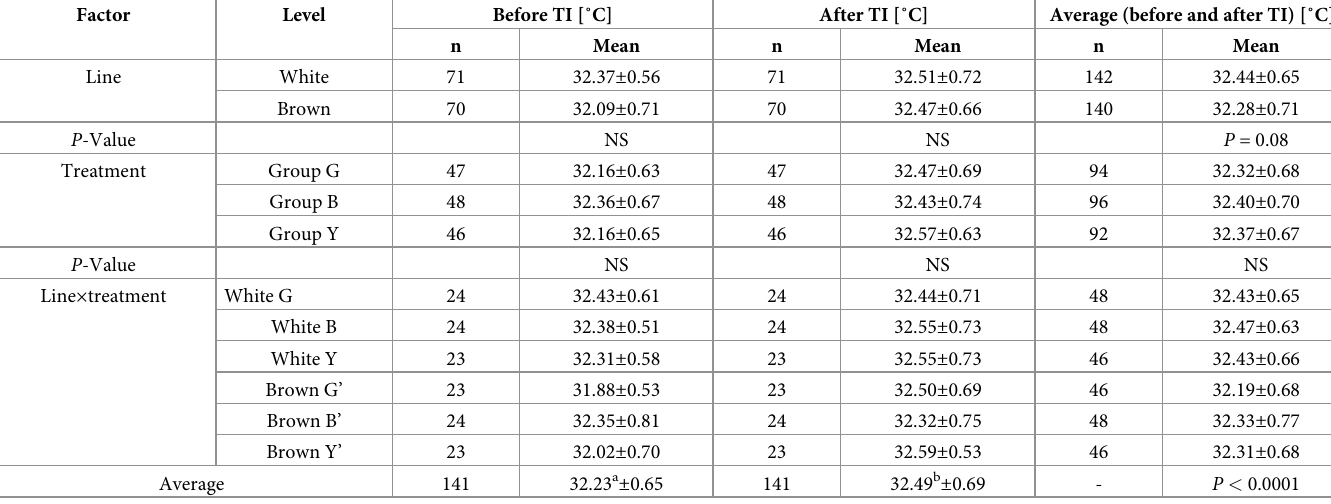
Table 2. Mean and standard deviations for line, treatment, line and treatment for the temperature of the left eye (LE). Factor